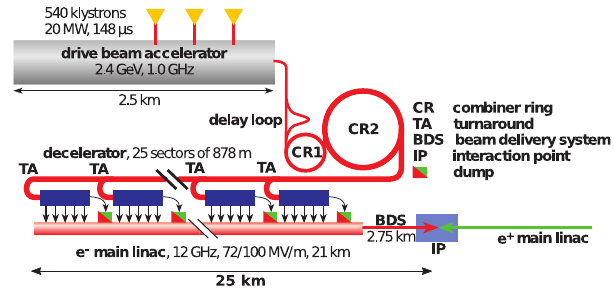
FIG. 1. Schematic of the CLIC drive-beam concept showing the electron acceleration complex